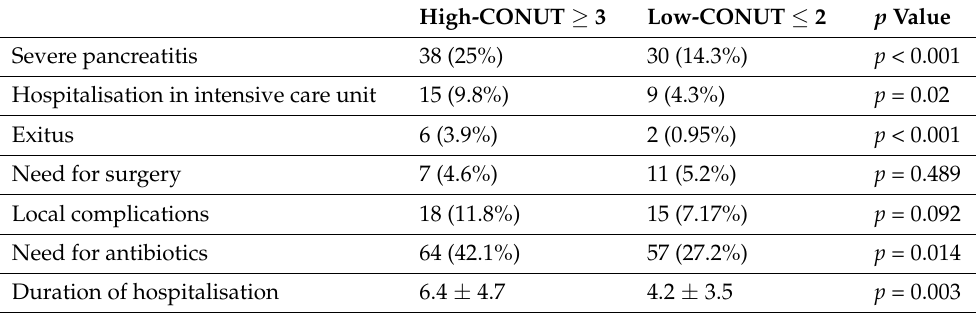
Table 3. Categorisations according to Controlled Nutritional Status (CONUT)